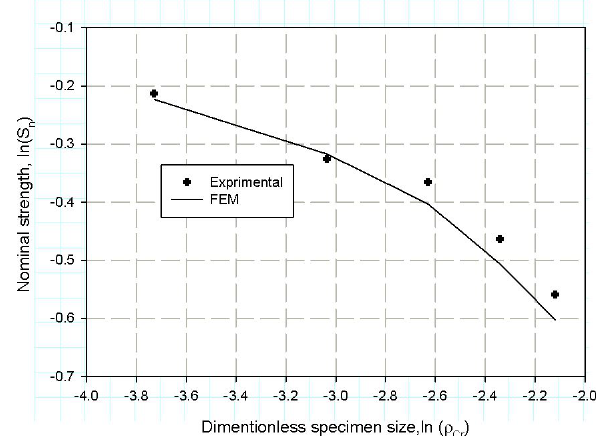
Fig. 6. FE prediction validation.